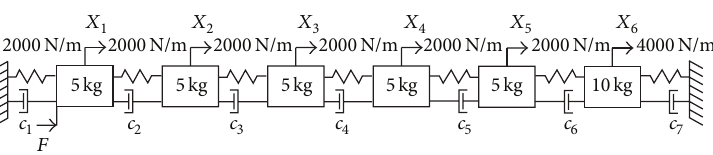
Figure 1: The benchmark 6-DOF system.